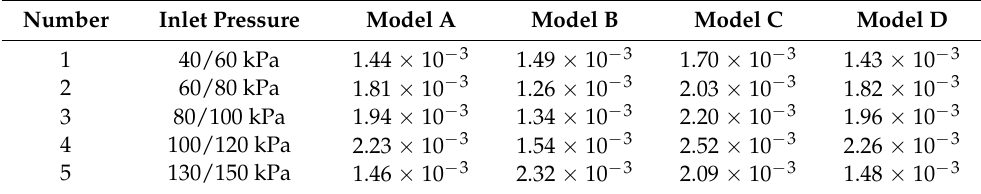
Table 2. Chi-square values of the model fitting results under different inlet